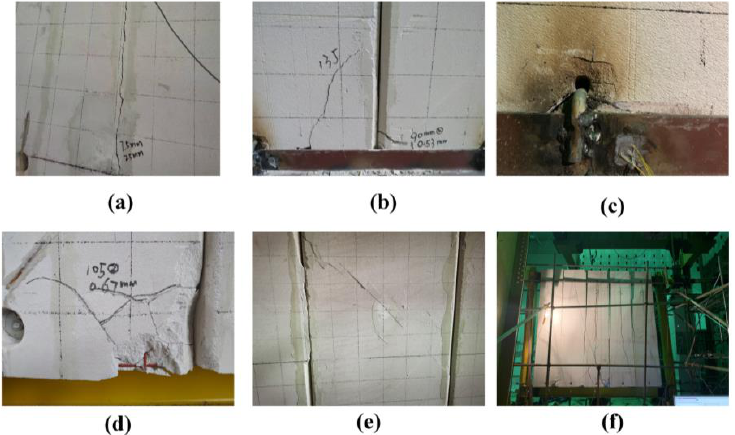
Figure 12. Images depicting the results of the loading test used for specimen SF-1: ( a ) splicing of the AAC wall panel due to mortar cracking; ( b ) mortar falling off from the spliced AAC wall panel; ( c ) cracks in bolt holes; ( d ) AAC wall panels damaged at the corners; ( e ) oblique cracks in the middle of the AAC wall panel; ( f ) overall view of the wall panel frame after the test.